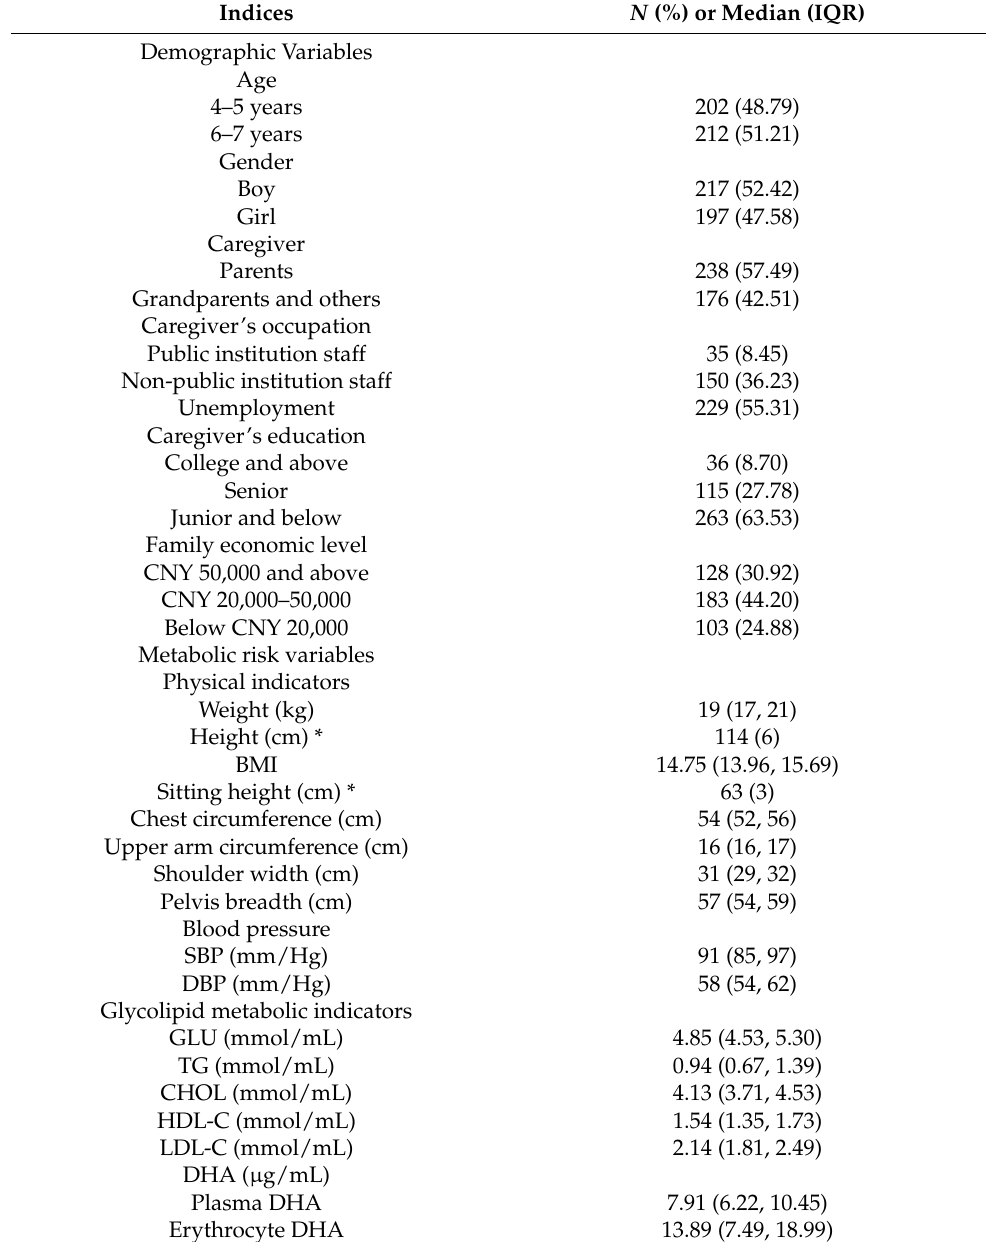
Table 1. The demographic characteristics and metabolic risk variables of children ( N =